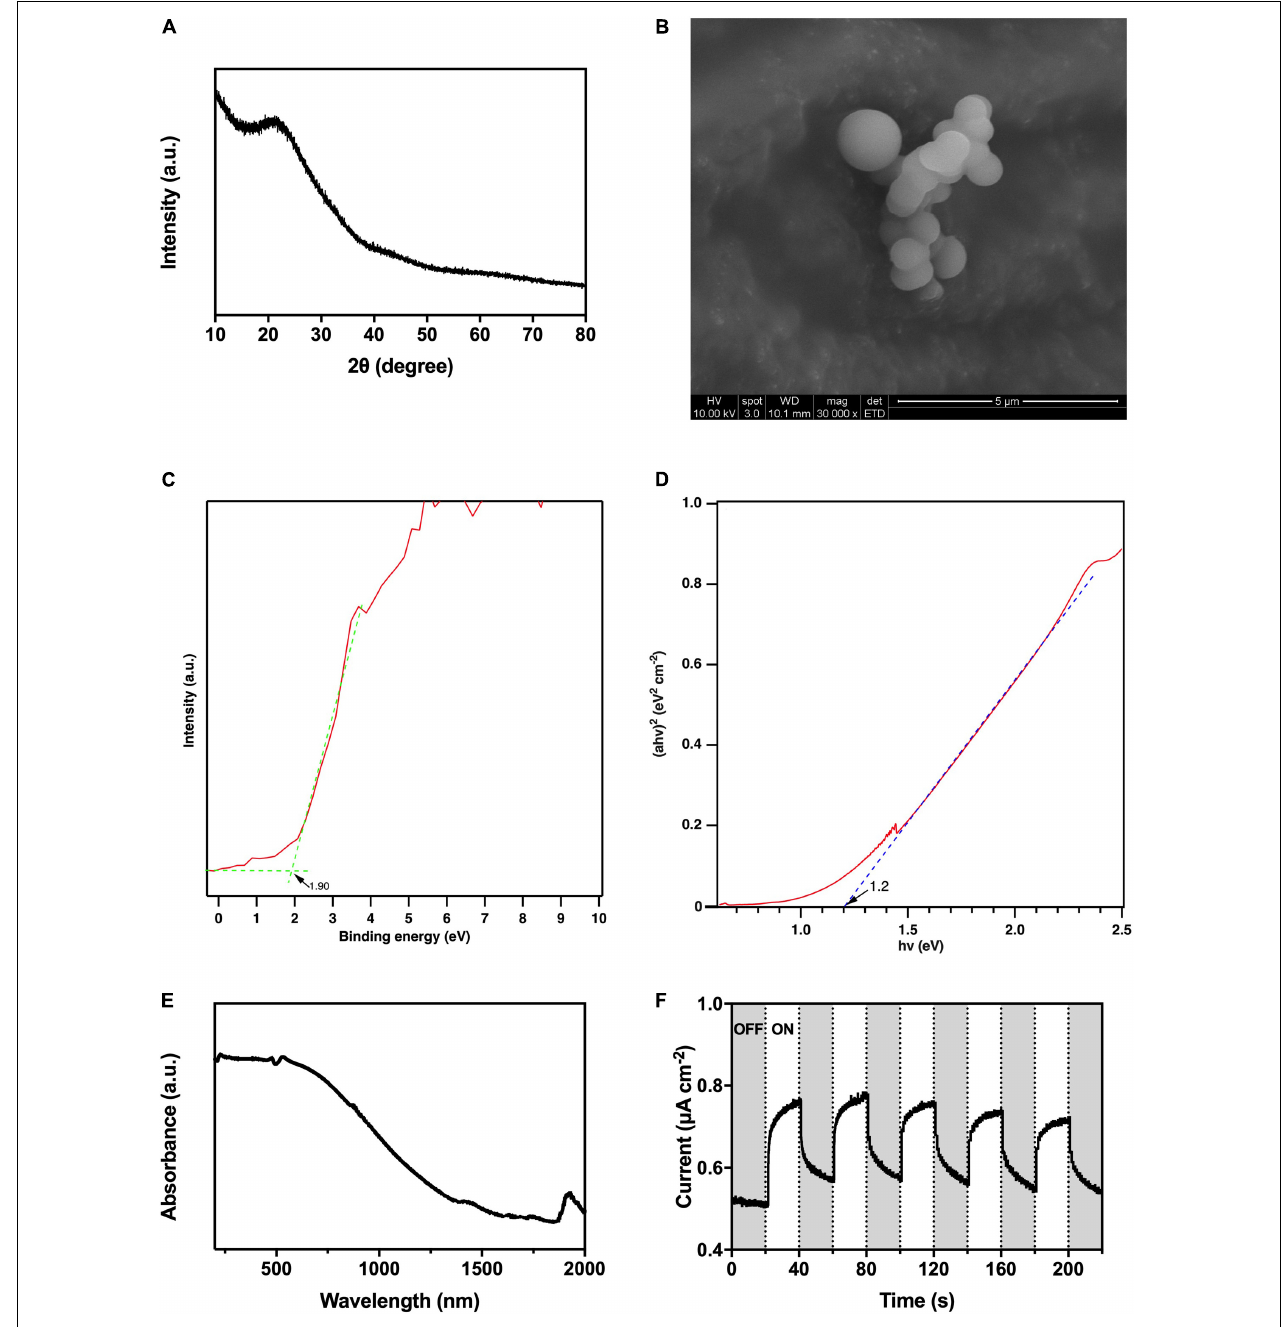
FIGURE 3 | Characterization of HTCC, (A) X-ray diffraction pattern, (B) scanning electron microscope images, (C) valence band X-ray photoelectron spectroscopy spectrum, (D) converted Kubelka–Munk plot, (E) ultraviolet–visible–near infrared diffuse reflectance spectrum, and (F) photocurrent responses under 2,000 W m − 2 VL irradiation.